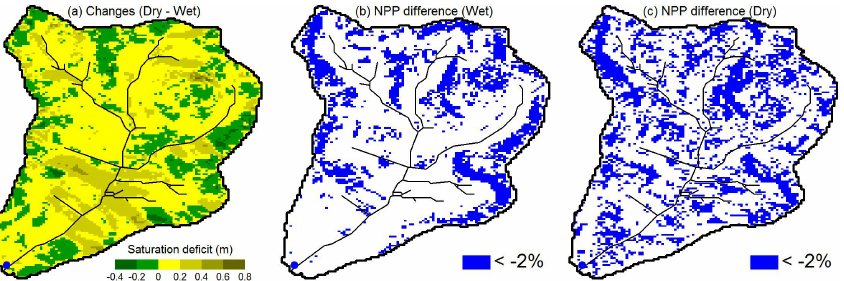
Fig. 10. (a) Deteriortation of soil moisture condition under the dry scenario compared to the wet scenario resulted in NPP decreases occurring in more areas of the watershed (c) under the dry scenario than that (b) under the wet scenario. The white areas show no significant